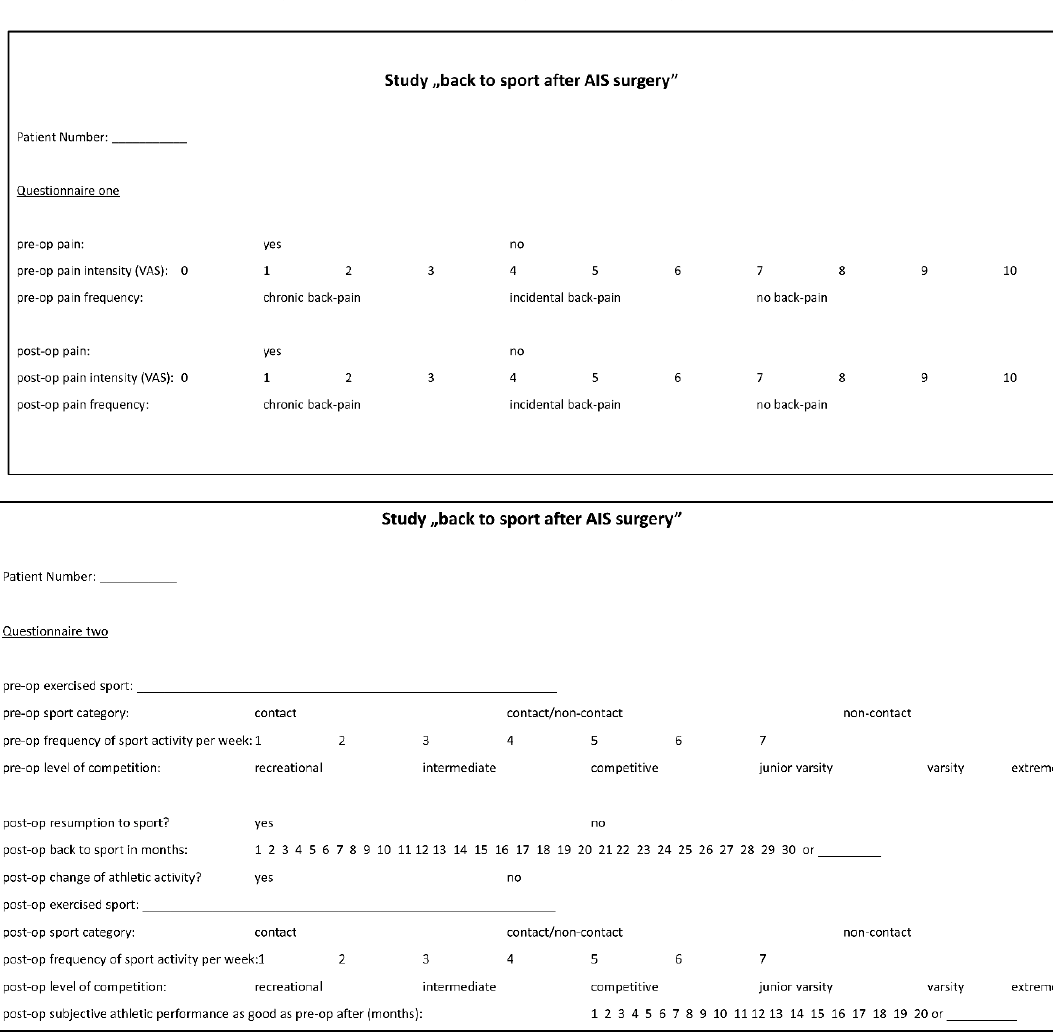
Figure 2. Questionnaires used for data acquisition. Table 1. Sport categories of the study cohort.